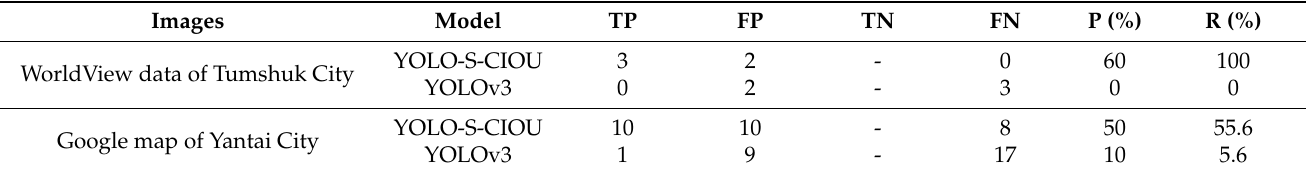
Table 3. Comparison of detection performance of YOLOv3 and YOLO-S-CIOU on remote sensing images. TP, FN, and FP are calculated according to the number of various points and boxes in Figures 12 and 13, and P and R are calculated according to the formula in Section